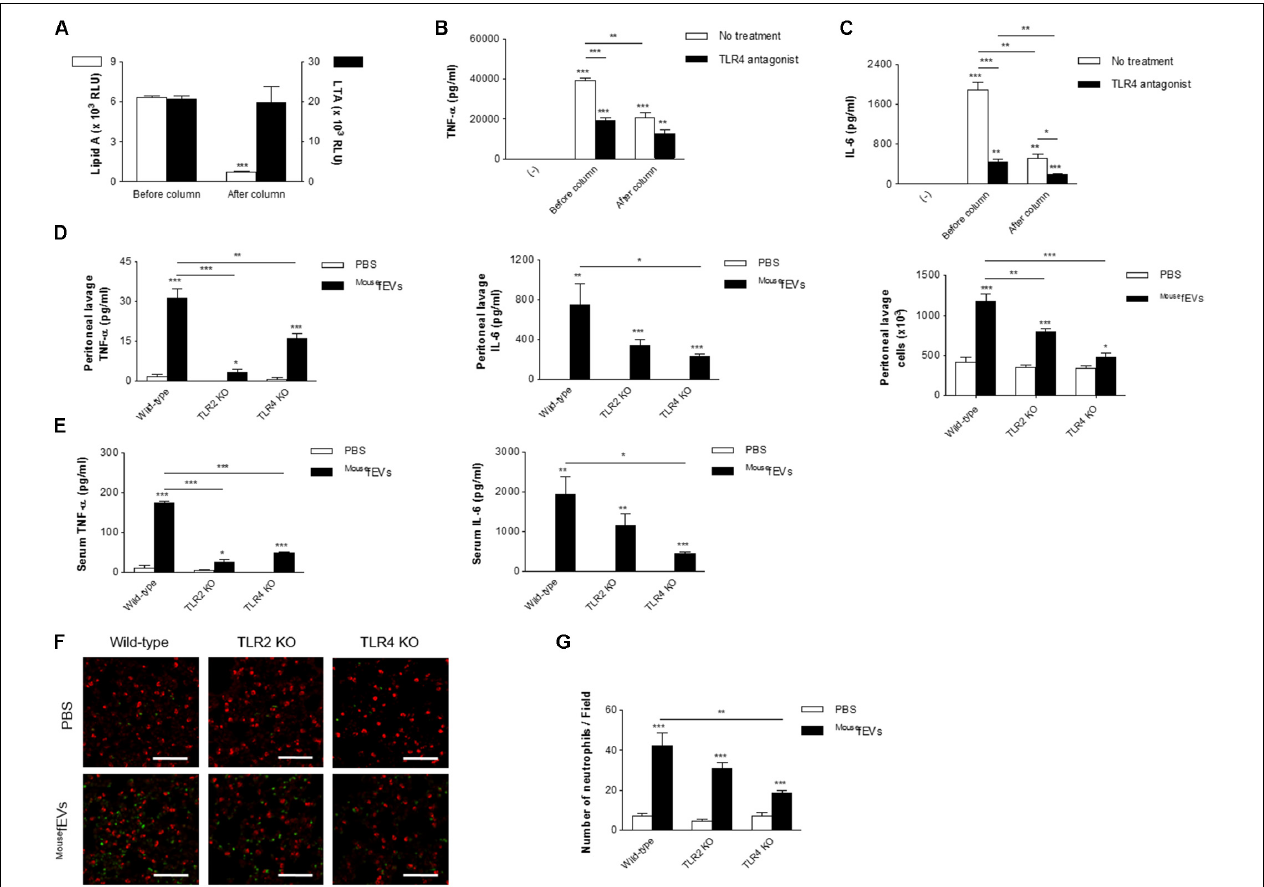
FIGURE 5 | Both TLR2 and TLR4 contribute to systemic inflammation induced by Mouse fEVs. (A) After passing Mouse fEVs through a polymyxin B column, which binds LPS, ELISA using anti-lipid A and anti-LTA antibodies showed efficient removal of LPS-positive EVs (Gram-negative bacterial EVs) in Mouse fEVs, but not of LTA-positive EVs (Gram-positive bacterial EVs) ( n = 3). (B,C) RAW264.7 cells were pre-incubated with vehicles (open bars) or TLR4 antagonist (closed bar; LPS from Rhodobacter sphaeroides , 1 µ g/mL) for 30 min, and treated with Mouse fEVs (5 µ g/mL in total protein concentrations), which either had or had not passed through the polymyxin B column, for 15 h, and the concentrations of TNF- α (B) and IL-6 (C) in the conditioned media were measured ( n = 3). (D,E) Wild-type, TLR2 KO, TLR4 KO mice were sacrificed at 3 h after intraperitoneal introduction of Mouse fEVs (100 µ g in total protein amounts). The concentrations of TNF- α and IL-6 in the peritoneal lavage fluids (D) and serum (E) were measured ( n = 5). The number of inflammatory cells in the peritoneal lavage fluids were also quantified (D) . (F,G) Wild-type, TLR2 KO, TLR4 KO mice were sacrificed at 3 h after intraperitoneal introduction of Mouse fEVs (100 µ g in total protein amounts). The lungs were excised after whole body perfusion and immediately fixed with paraformaldehyde, sectioned at 4 µ m thickness, and subsequently stained with markers for neutrophils (anti-Ly6C/G antibody; green), and alveoli (anti-SP-C antibody; red). The lung images were acquired with a confocal microscope (F) . Scale bar = 100 µ m. The numbers of Ly6C/G-positive cells per field were calculated (G) ( n = 7). ∗ P < 0.05, ∗∗ P < 0.01, and ∗∗∗ P < 0.001, respectively, when the data were compared to ( − ) or PBS group. Error bars indicate